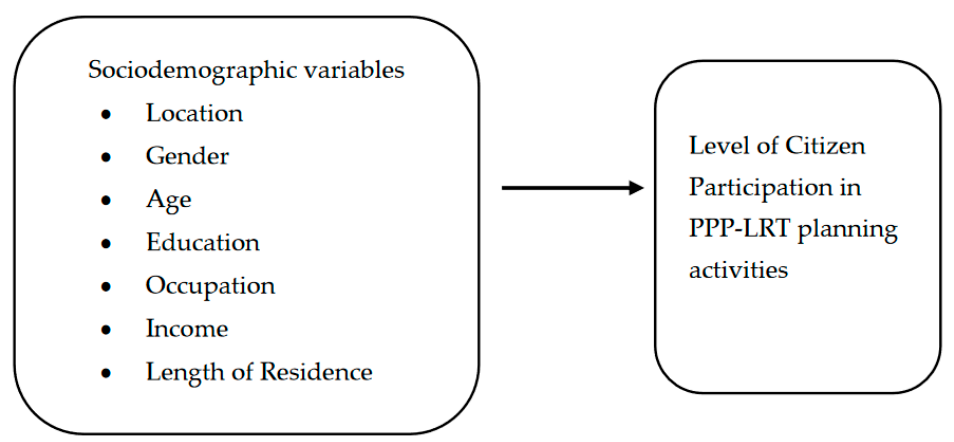
Figure 1. Associations between sociodemographic factors and citizen participation (Nyama and Mukwada 2022). Mukwada